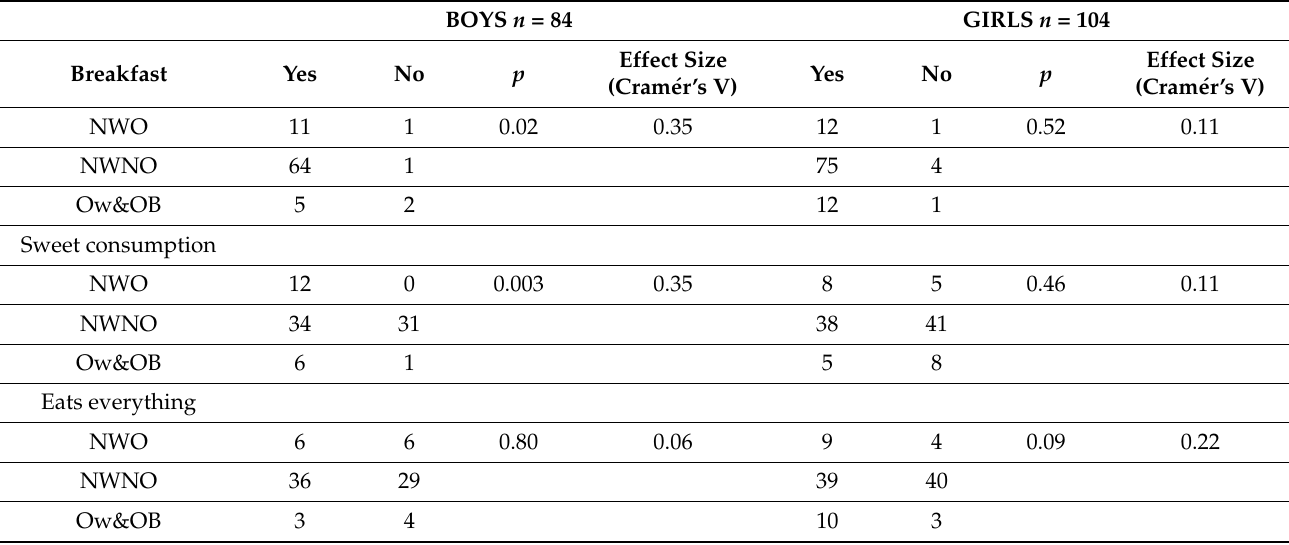
Table 6. Frequencies of responses in dichotomously scored items from the Czech screening questionnaire for parents monitoring basic eating